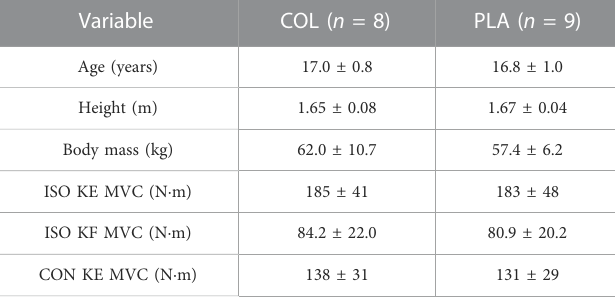
TABLE 1 Participant baseline characteristics. Data are mean ±